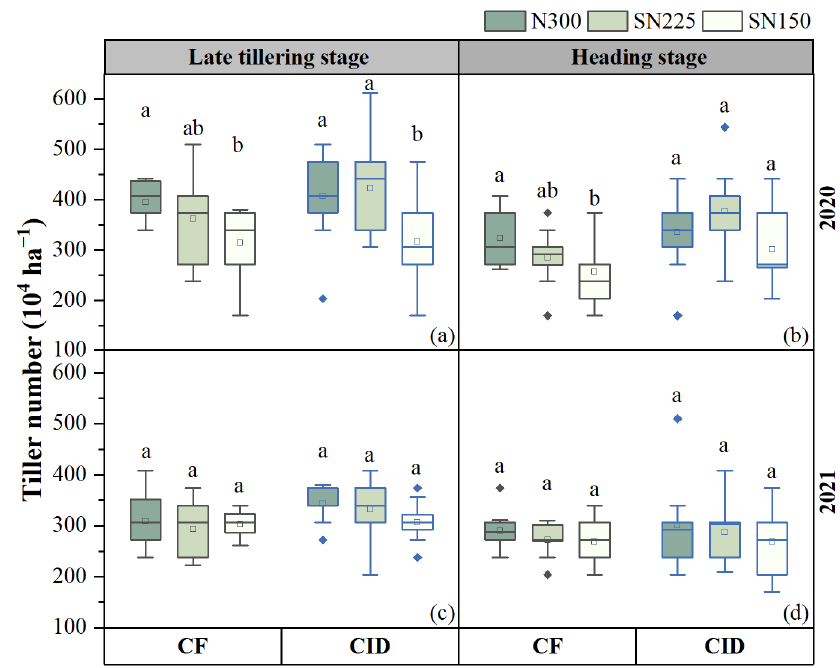
Figure 4. Tiller number of Nanjing 9108 rice variety ( Oryza sativa L.) under two water regimes (continuously flooded [CF] and controlled irrigation and drainage [CID]) and three fertilizer practices (conventional farmers’ fertilization of 300 kg N ha − 1 without straw return [N300], straw return with 225 kg N ha − 1 fertilizer [SN225], and straw return with 150 kg N ha − 1 fertilizer [SN150]) at the late tillering and heading stages in the 2020 ( a , b ) and 2021 ( c , d ) rice-growing seasons. The squares, lines, and diamonds in boxplots represent the means, medians and outliers, respectively. Different letters indicate significant differences at p < 0.05. Table 1. Analysis of variance of water regime and N-fertilizer management and their interactions with morphological, photosynthetic and fluorescence indicators.